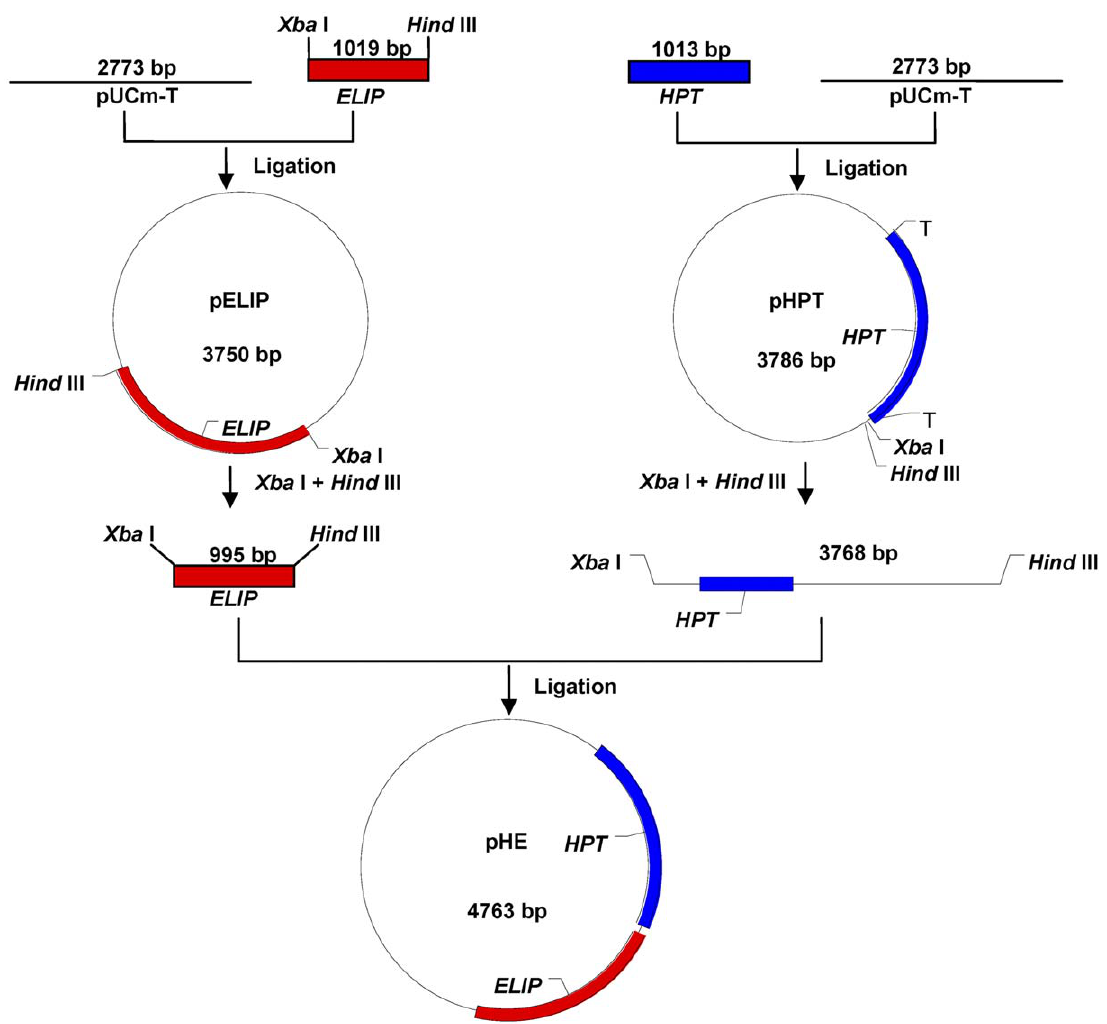
Figure 2. Construction of recombinant plasmid pHE. pELIP: plasmid harboring tomato ELIP gene; pHPT: plasmid harboring Escherichia coli HPT gene; pHE: plasmid harboring both tomato ELIP and E. coli HPT gene.